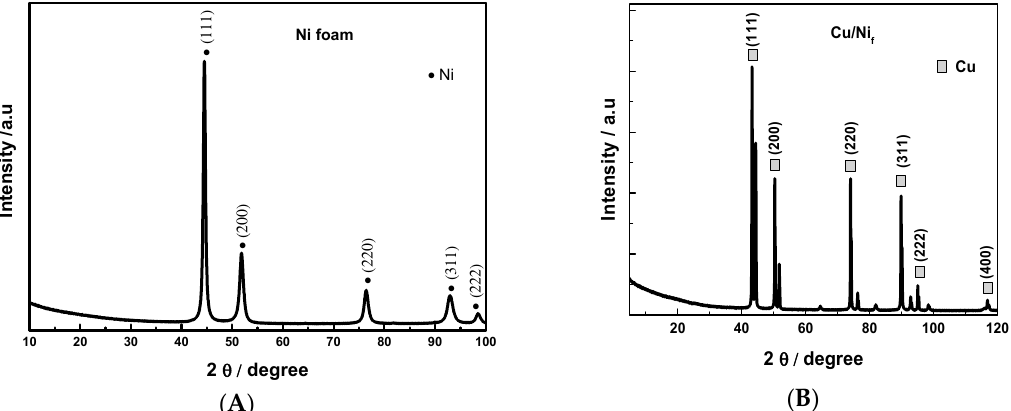
Figure 3. X-ray di ff ractograms for electrodeposited Ni foam at 1 A / cm 2 for 3 min. ( A ) and for Cu / Ni f Figure 3. X-ray diffractograms for electrodeposited Ni foam at 1 A/cm 2 for 3 min. ( A ) and for Cu/Ni f electrode ( B ) (Cu electrodeposited onto Ni foam at 35 mA / cm 2 for 15 min.). electrode ( B ) (Cu electrodeposited onto Ni foam at 35 mA/cm 2 for 15 min.). The resulting Cu / Ni f electrode was then subjected to electrochemical